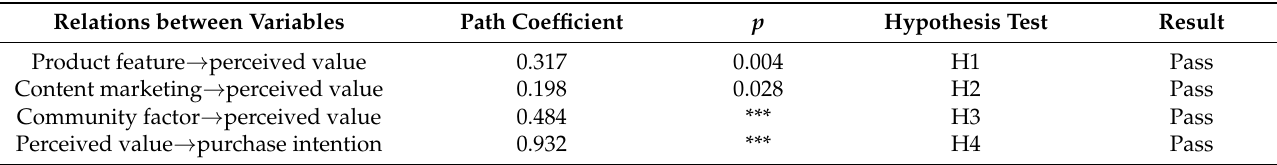
Table 9. Standard-coefficient and hypothesis-test